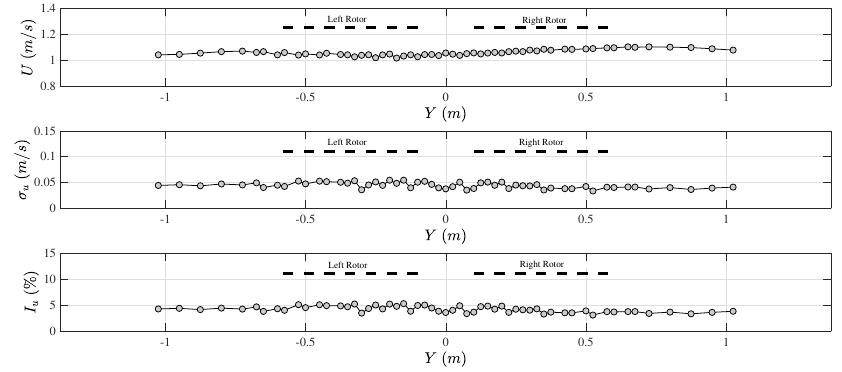
Figure 8. Inflow horizontal profile characteristics at hub height, h hub , from 3 d T upstream of RM1: mean streamwise velocity, ¯ u (top), streamwise velocity root-mean squared, σ u = and streamwise turbulence intensity, I u (bottom). Y -axis distance shows full channel width, b = 2.75 m.